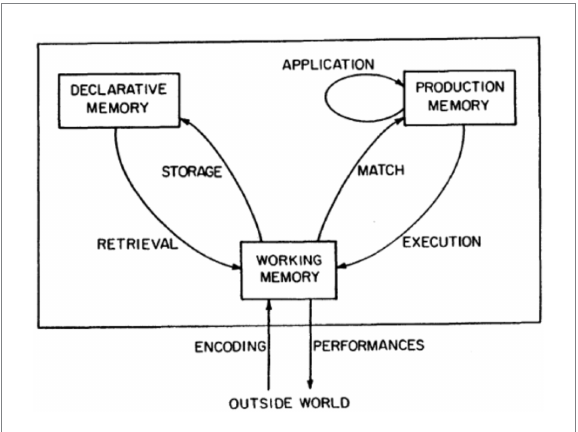
FIGURE 1 Framework for the ACT (Anderson, 1983, p.